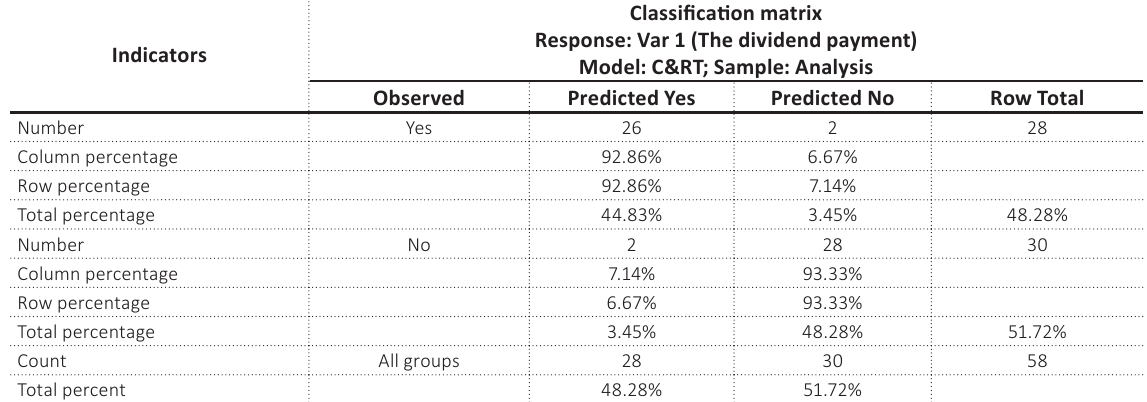
Table 1. Classification accuracy